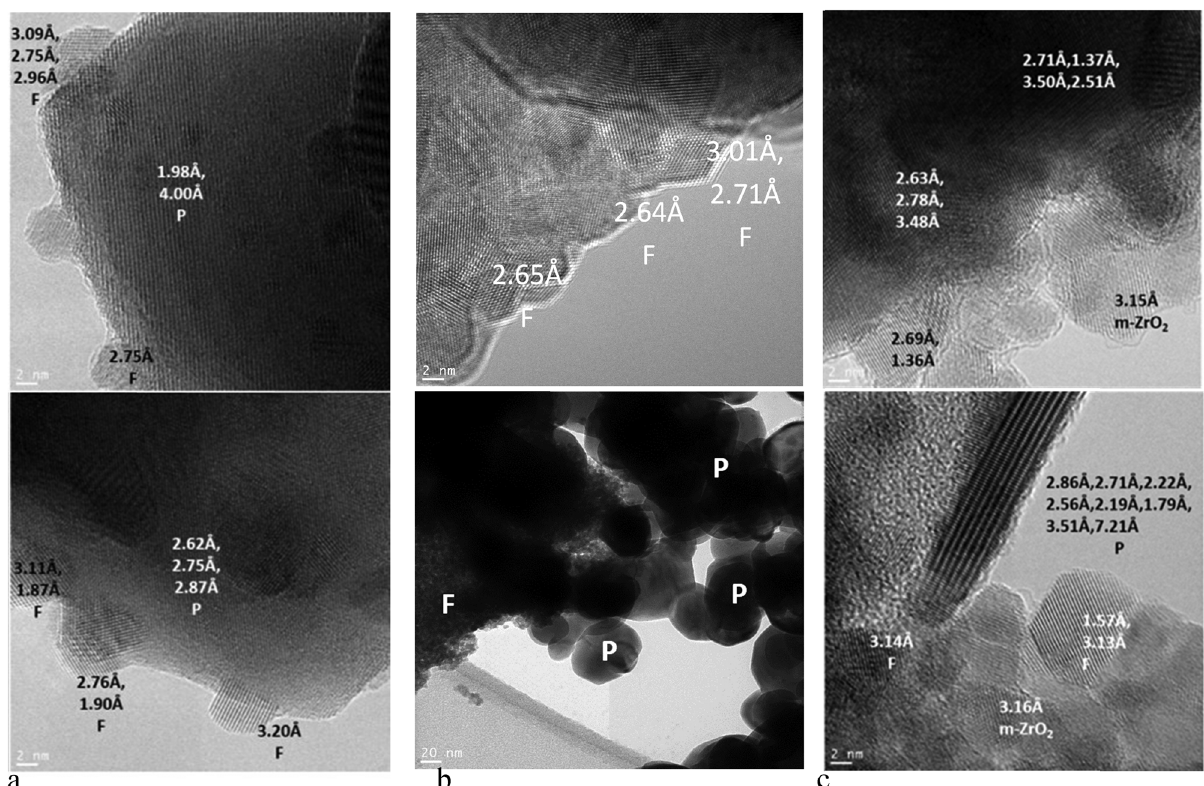
Figure 2: HR TEM images of as - prepared ( a ) Sim1, ( b ) Sim2 and ( c ) Sim3 ( P – perovskite, F – fl uorite )